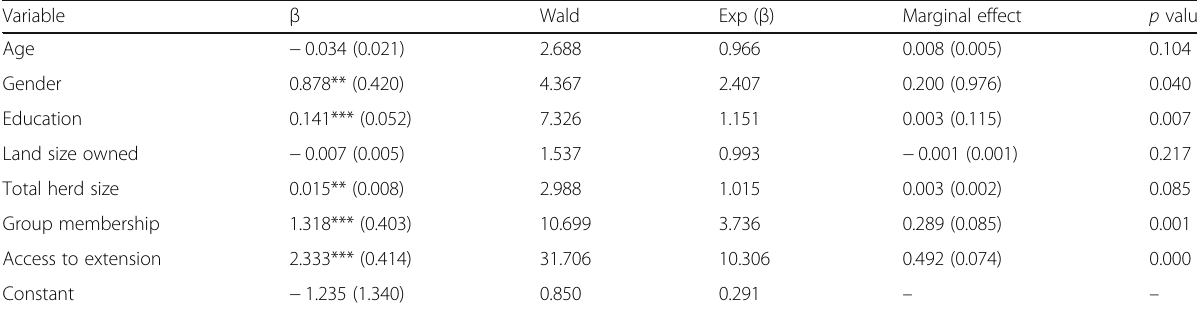
Table 5 Logit model estimates for the determinants of household ’ s participation in fodder production Variable